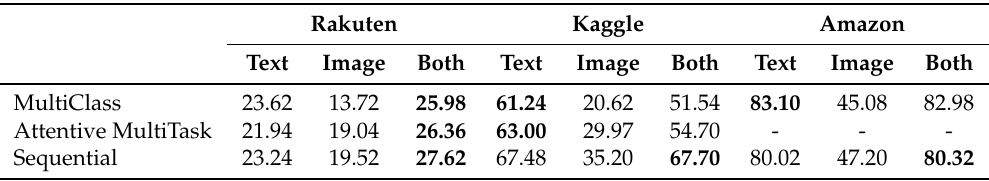
Table 6. Full-chain attribute accuracy on the test sets of all datasets comparing only text, image-only and multimodal